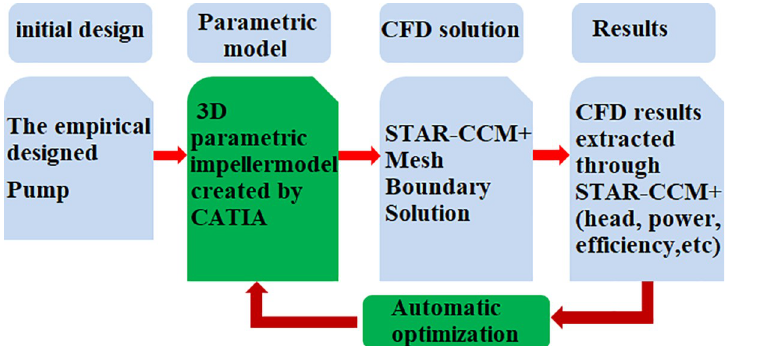
Fig 5. Flowchart of pump hydraulic performance